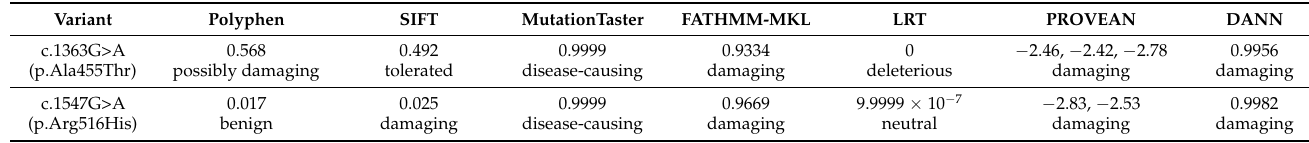
Table 2. In Silico Analysis of PMPCA Missense Variants.